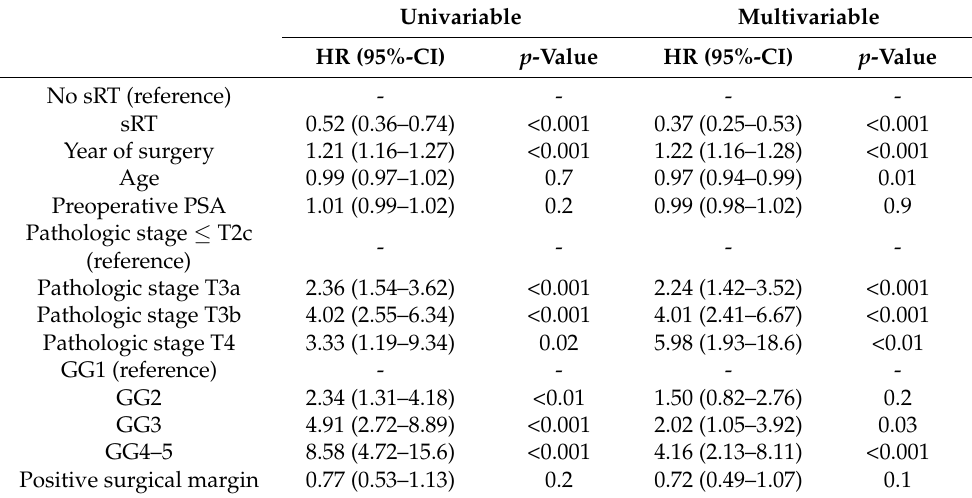
Table 2. Uni- and multivariable Cox regression predicting metastasis of patients with biochemical recurrence after radical prostatectomy and 1:1 matching, stratified according to salvage radiotherapy vs. observation.